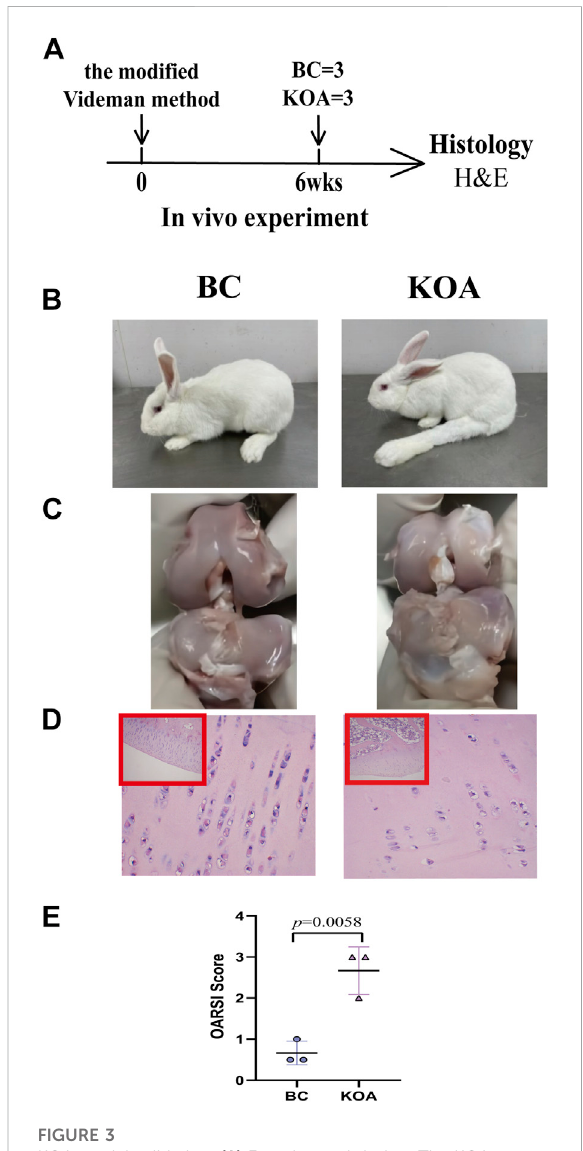
FIGURE 3 KOA model validation. (A) Experimental design. The KOA model rabbits were treated with the modi fi ed Videman modeling. The rabbits were killed 6 weeks after surgery for macroscopic observation and histological analysis ( n = 3/group). (B) Outward and (C) anatomical appearance of rabbit knee joint. (D) Representative images and (E) histomorphometric analyses of H&E-stained sections for OARSI score. The images are magni fi ed 100×(inside the red rectangular frame) and 400×. Mann – Whitney test was used for the comparing OARSI scores. The data are presented as the mean ± SD. Speci fi c p- values of comparison are